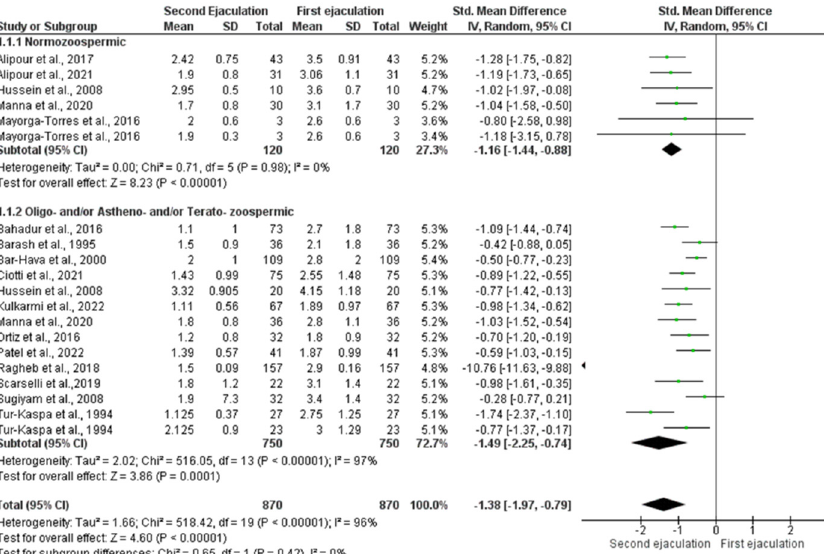
Figure 2. Forest plot of studies that evaluated the effects of a very short abstinence period on